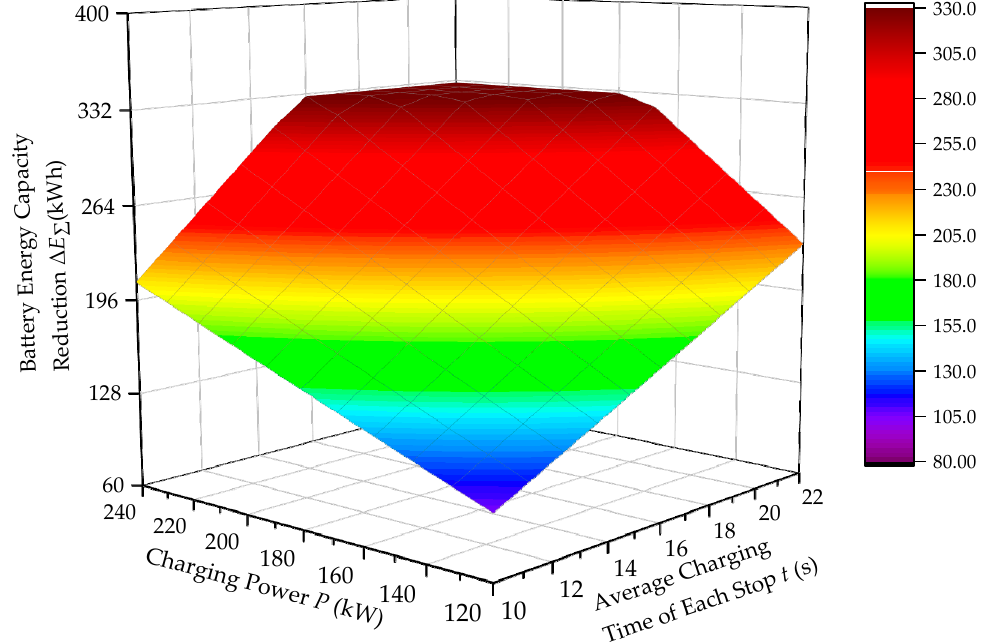
Figure 9. The e ff ects of the charging time on the battery energy capacity reduction under di ff erent Figure 9. The effects of the charging time on the battery energy capacity reduction under different charging charging power.